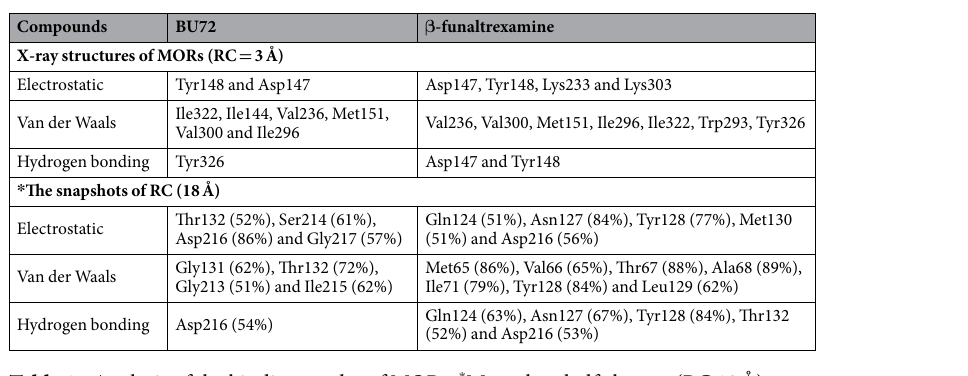
Table 1. Analysis of the binding modes of MORs. * More than half chance: (RC 18